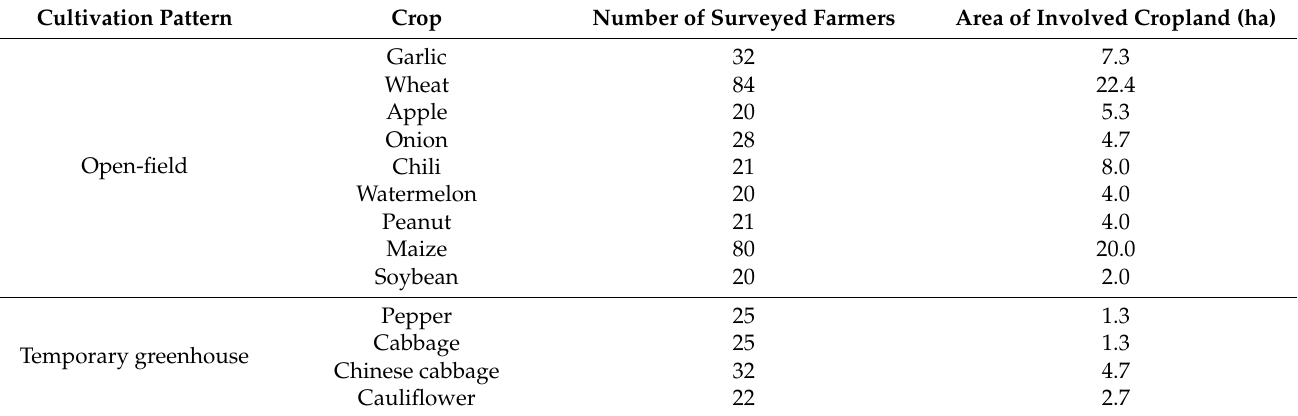
Table 1. Summary information of the survey: crop kinds, number of farmers, and planting area of different